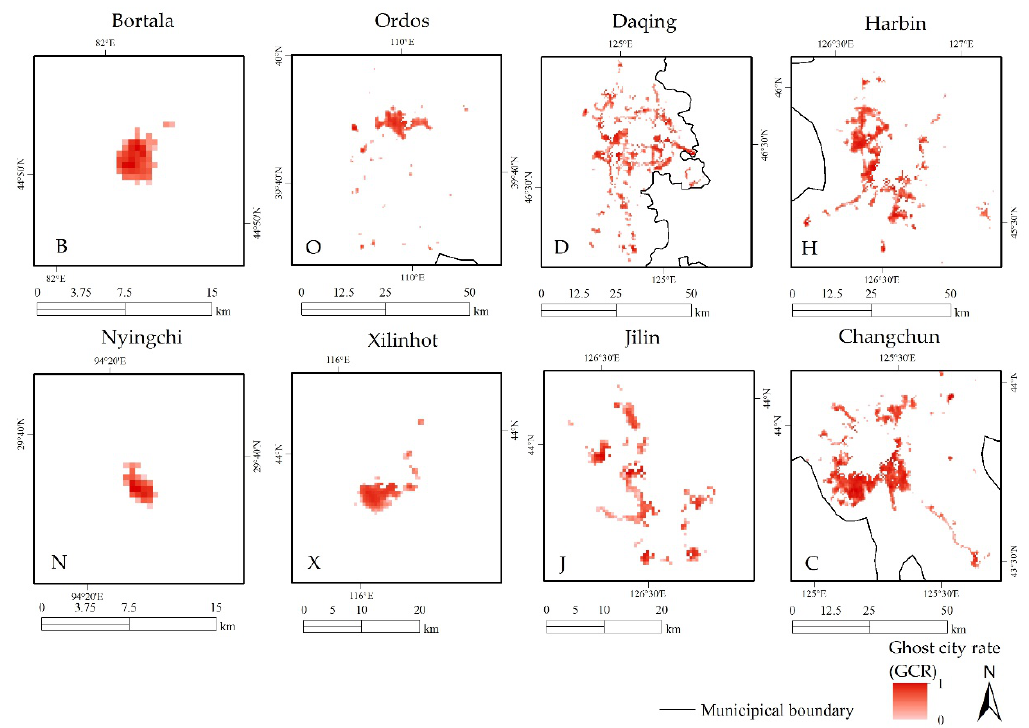
Figure 8. Different spatial patterns of eight ghost cities, four in eastern China (D, Daqing, AGCR is 46.22%; J, Jilin, AGCR is 40.9%; H, Harbin, AGCR is 52.23%; C, Changchun, AGCR is 55.35%), two in central China (O, Ordos, AGR is 47.16%; X, Xilinhot, AGCR is 46.94%), and two in western China (B, Bortala, AGCR is 41.32%; N, Nyingchi, AGCR is 47.26%); and the black lines in the figures are the municipal administrative boundaries.